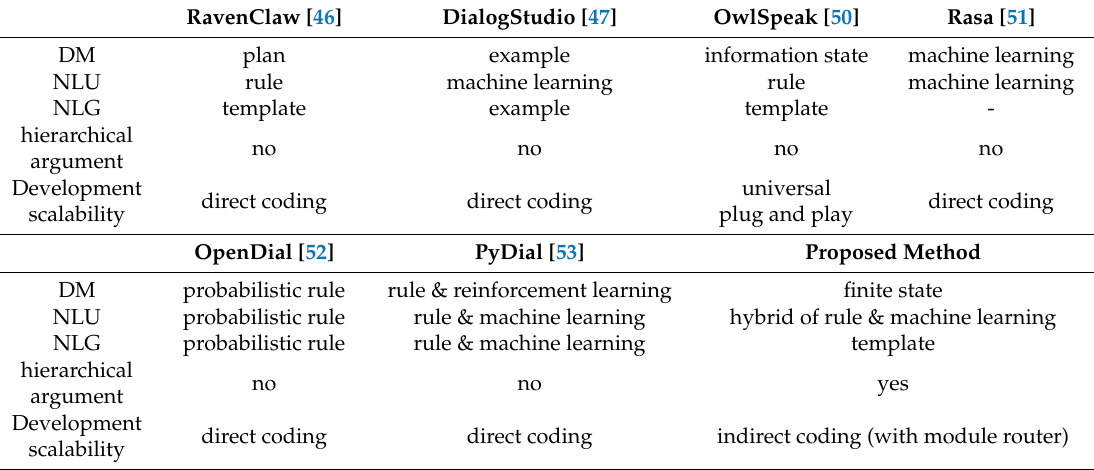
Table 4. Comparison of dialog